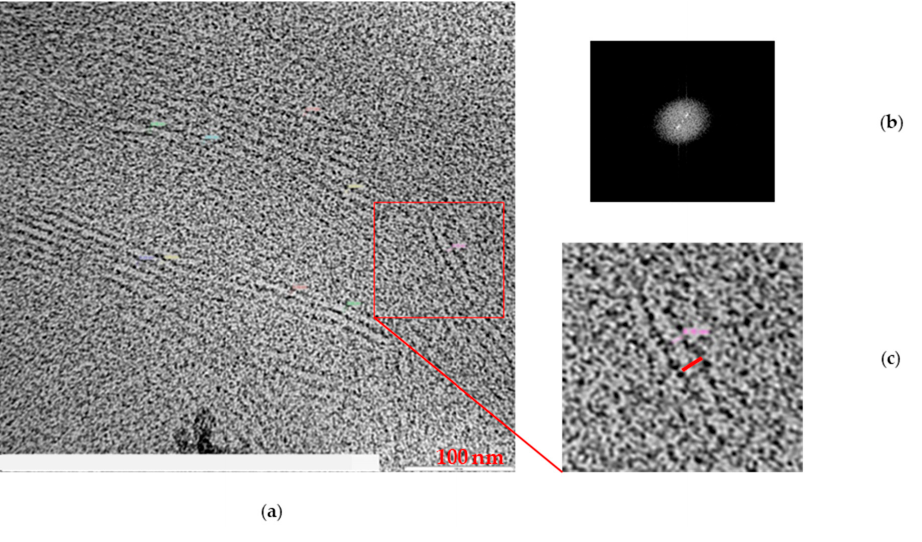
Figure 10. TEM image of PB1 ( a ), FFT signal ( b ), lamella image ( c ).